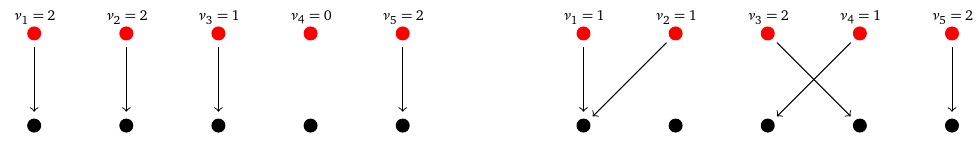
Figure 1: Sketch of two examples of a function f from p ’s in red to q ’s in